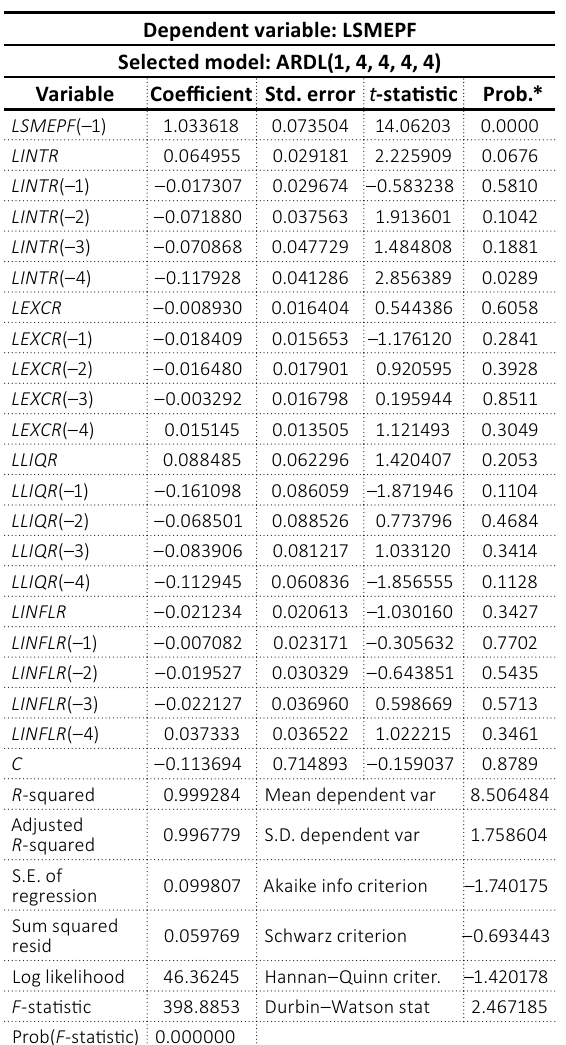
Table 5. ARDL short-run dynamics